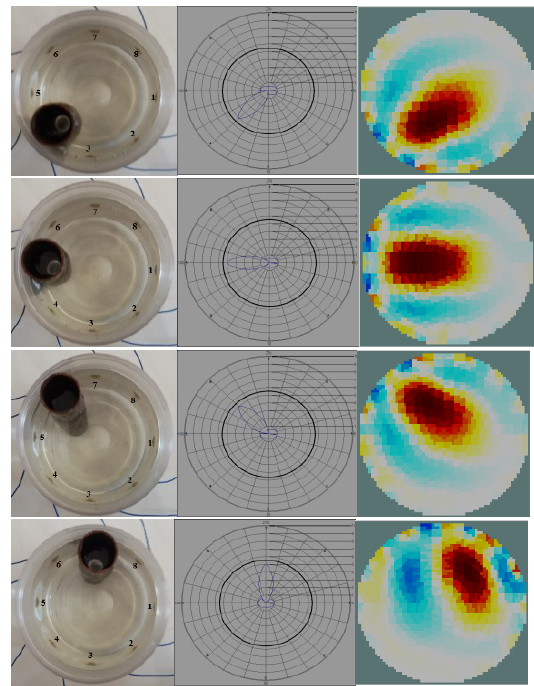
Fig. 5: Compiled one object test results for different locations.